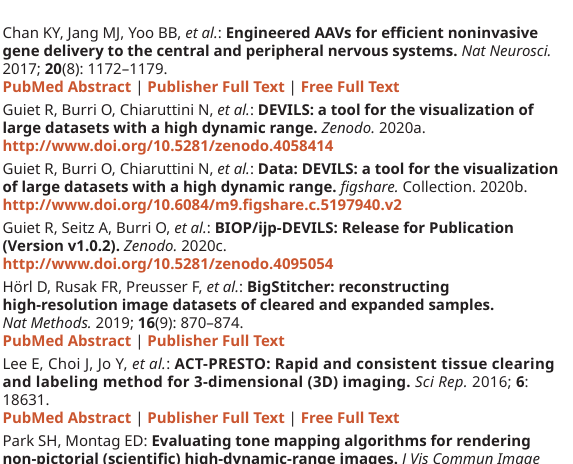
Extended data Zenodo: DEVILS: a tool for the visualization of large datasets with a high dynamic range. https://doi.org/10.5281/zenodo.4457159 (Guiet et al. ,